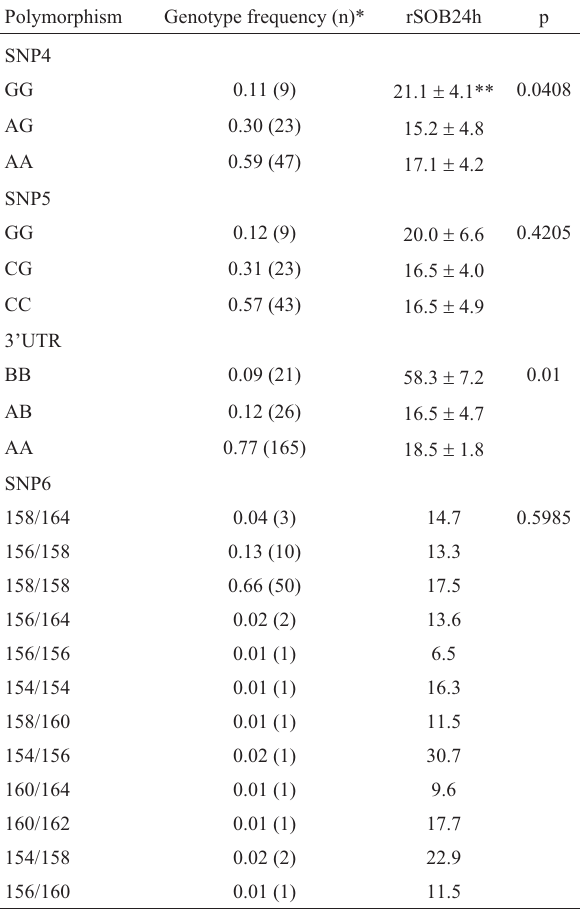
Table 5 - Effect of Slc11a1 polymorphism on bacterial survival in vitro